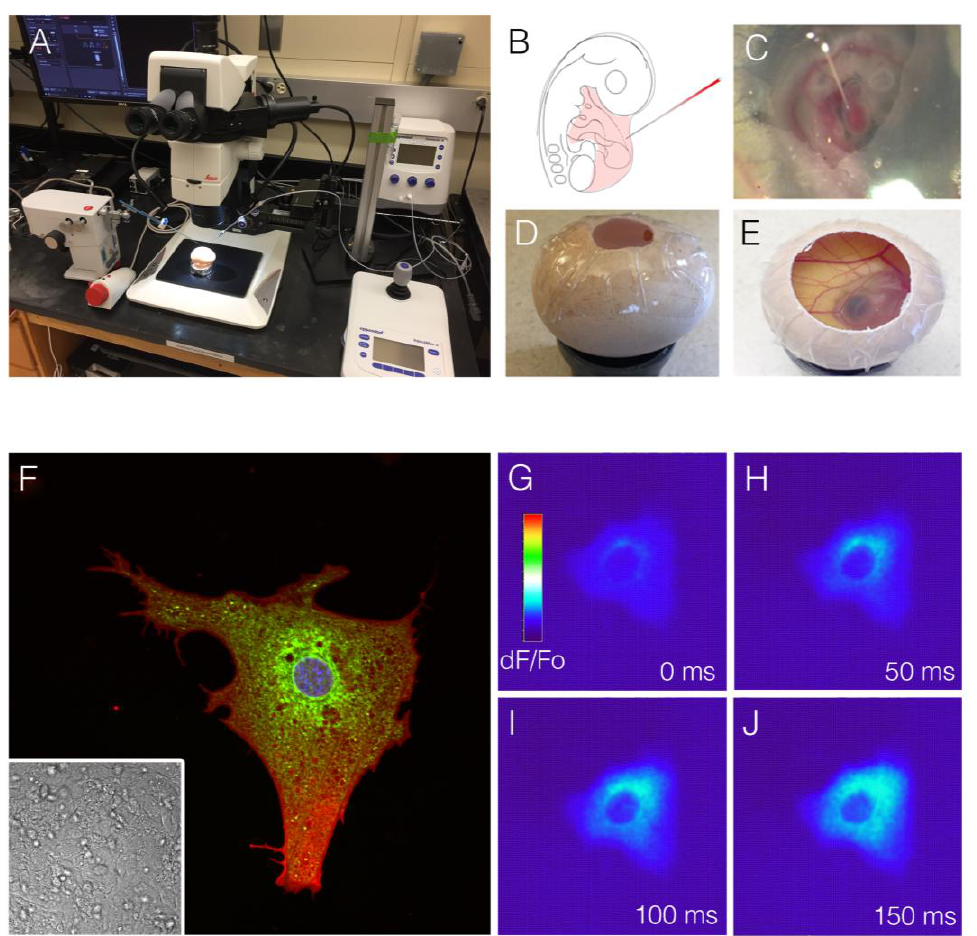
Figure 5. Mosaic analysis for imaging cardiac cell physiological maturation. ( A ) Microinjection system for viral- or plasmid-based transduction of cardiac cells; ( B ) Diagram of microinjection into the pericardial space of a chick embryo; ( C ) Photograph of injection procedure from ( B ); ( D , E ) Sealing and incubation of microinjected embryo to desired stage; ( F ) Embryonic cardiomyocyte transfected in vivo with a construct containing a membrane-targeted RFP, a sarcoplasmic-reticulum-targeted eGFP, and a nuclear-targeted BFP. This cell exists within a field of untransfected cardiomyocytes, as indicated by the phase contrast image (inset); ( G – J ) Time series of a cardiomyocyte from a similar stage as that depicted in ( F ), transfected with a construct encoding for the calcium indicator GCaMP6F. Cell was imaged at 100 frames per second. Calcium transients can be seen initiating in a perinuclear region (similar to the dense area of sarcoplasmic reticulum from ( F )) and propagating out towards the cell periphery.